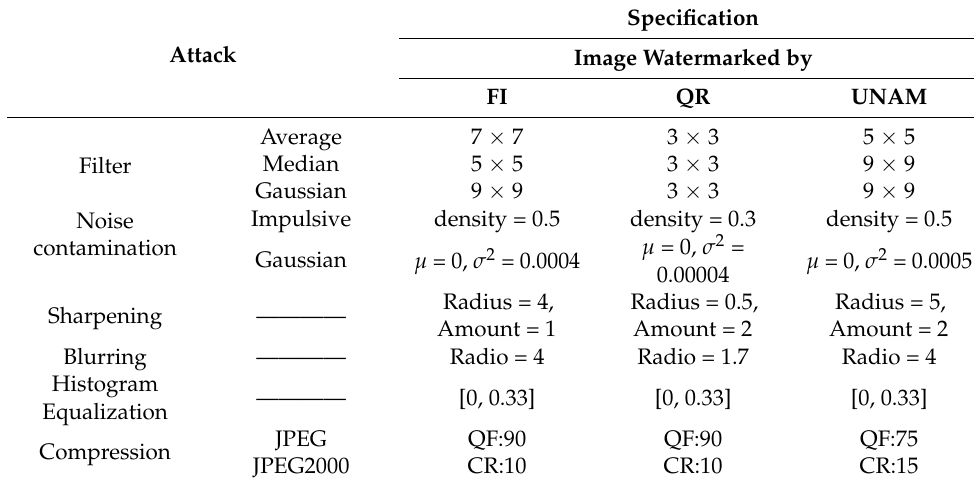
Table 3. Common image processing attacks used for the